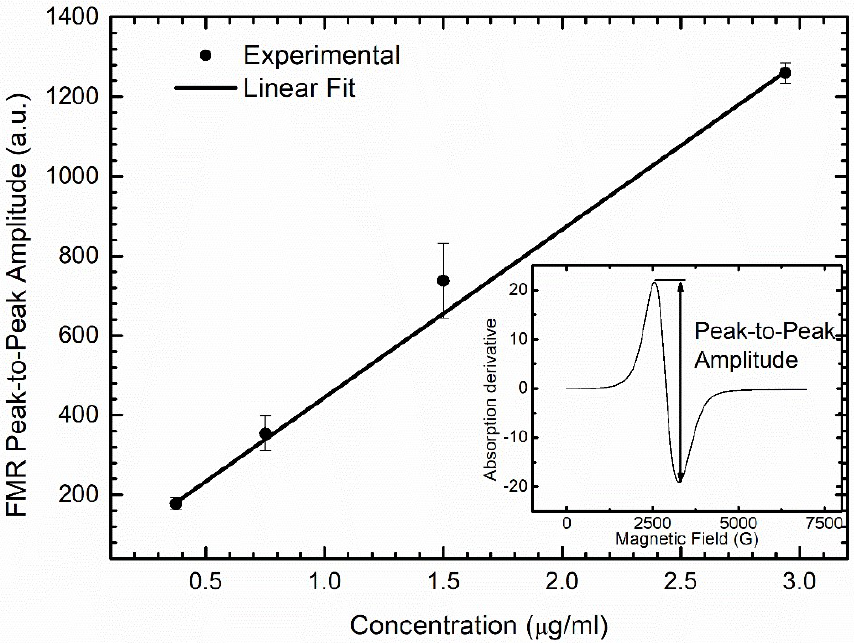
Figure 1. Results of peak-to-peak amplitude of FMR spectrum of water-diluted DMSA-MNP samples versus concentration. The linear equation obtained by fitting the peak-to-peak amplitude Ap-p, as a function of concentration C in (µg/mL) was Ap-p = 22.8 + 421.9C.